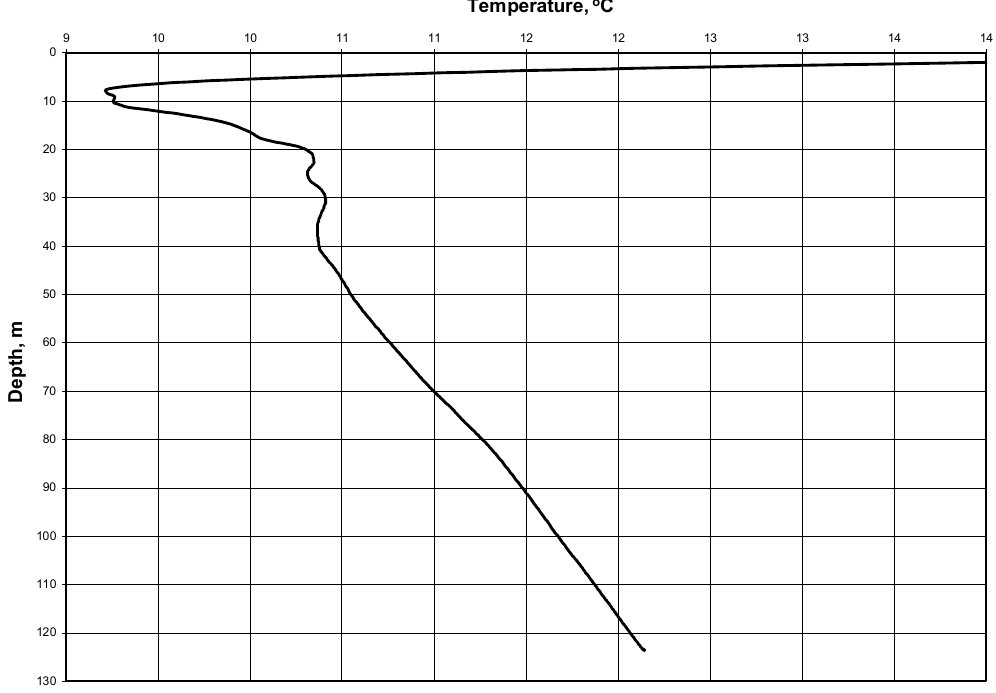
Figure 1. Natural (undisturbed) temperature profile of the BHE in Ż arów.